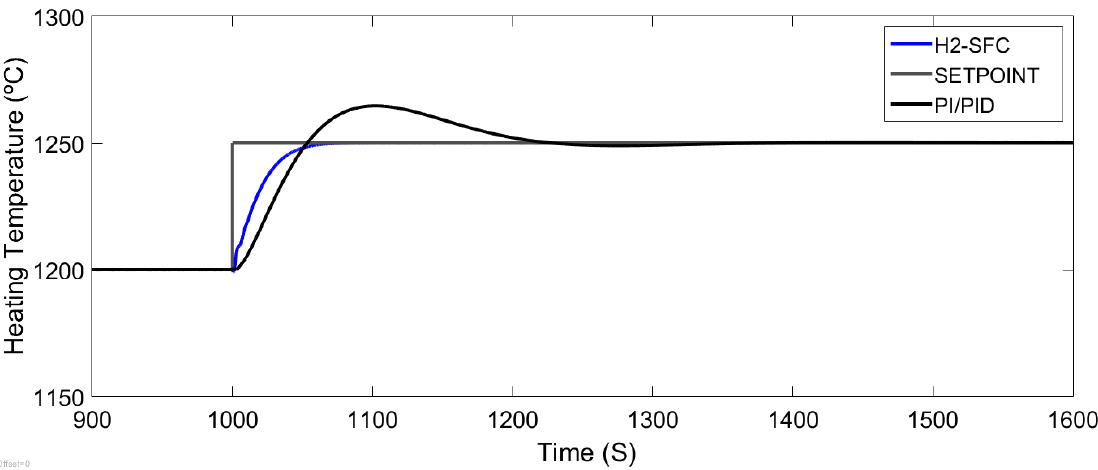
Figure 9. Time responses with H 2 -SFC and PID controllers in the presence of an internal disturbance.